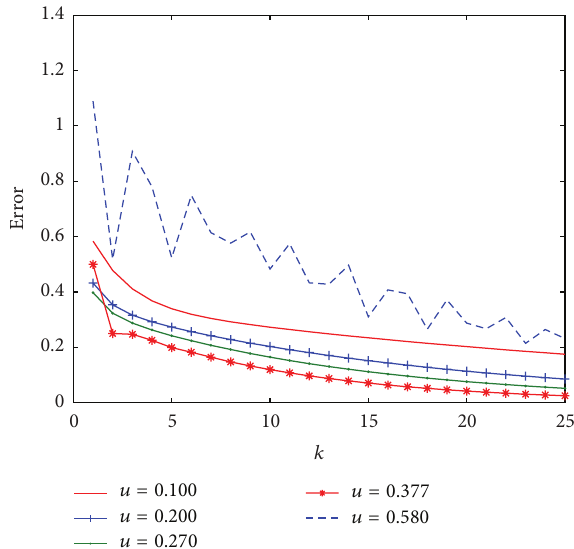
Figure 4: Comparison of convergence curves. and to be min {2/𝜆 max (𝐴𝐴 𝑇 ), 2/𝜆 max (𝐵𝐵 𝑇 )} = 0.377 in MGBI algorithm. The relative error 𝛿 := ‖𝑋 𝑘 − 𝑋‖/‖𝑋‖ is recorded in Figure 3. From the figure, we can also see that the MGBI algorithm converges faster than the GBI